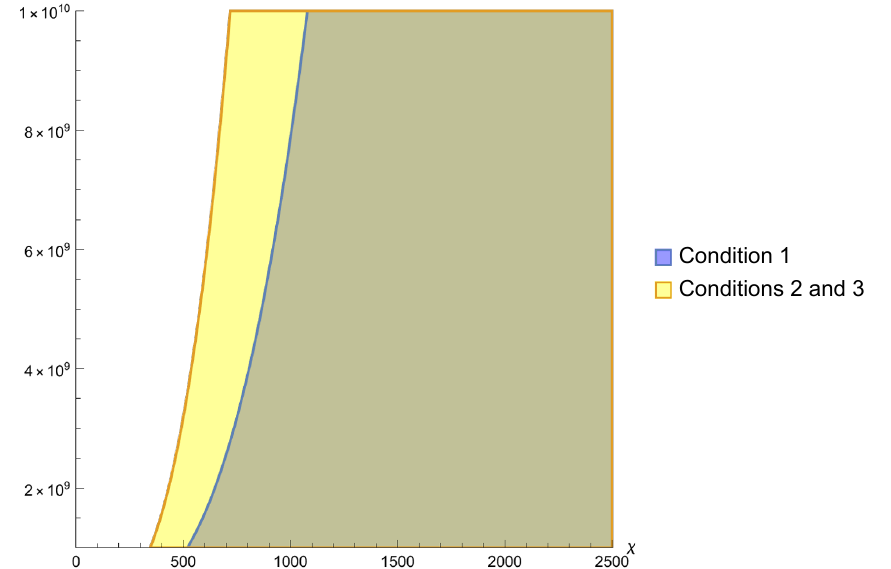
Figure 3 . Regions satisfying the island conditions are shown for a flat universe with w = 3 . 2 , ρ 0 = 10 − 6 , T 0 = 10 − 4 .